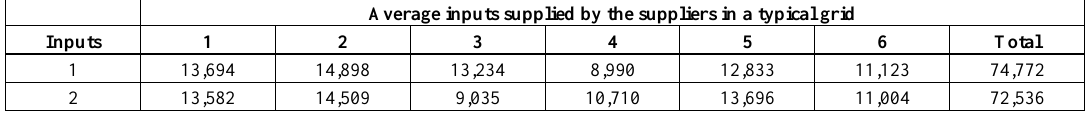
Table 2. Typical average amount of inputs supplied by 6 suppliers in grid 1 Average inputs supplied by the suppliers in a typical grid